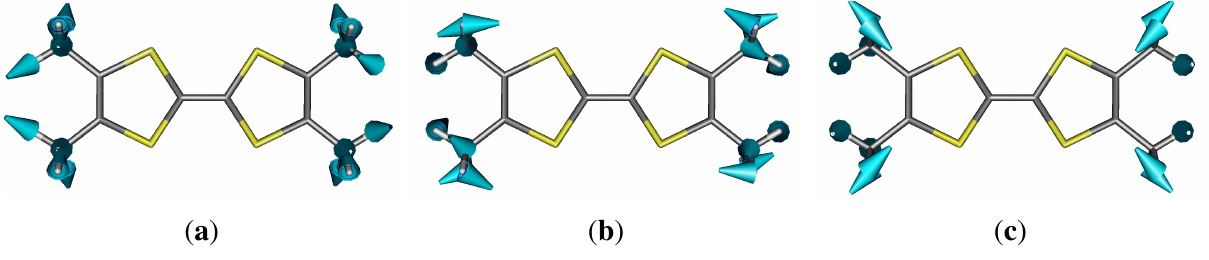
Figure A5. Eigenvectors of the seven ungerade ( b ( b ) mode; ( b ) ν ( a ) ν 66 3 u ( b ) mode; ( g ) ν mode; ( f ) ν 71 3 u